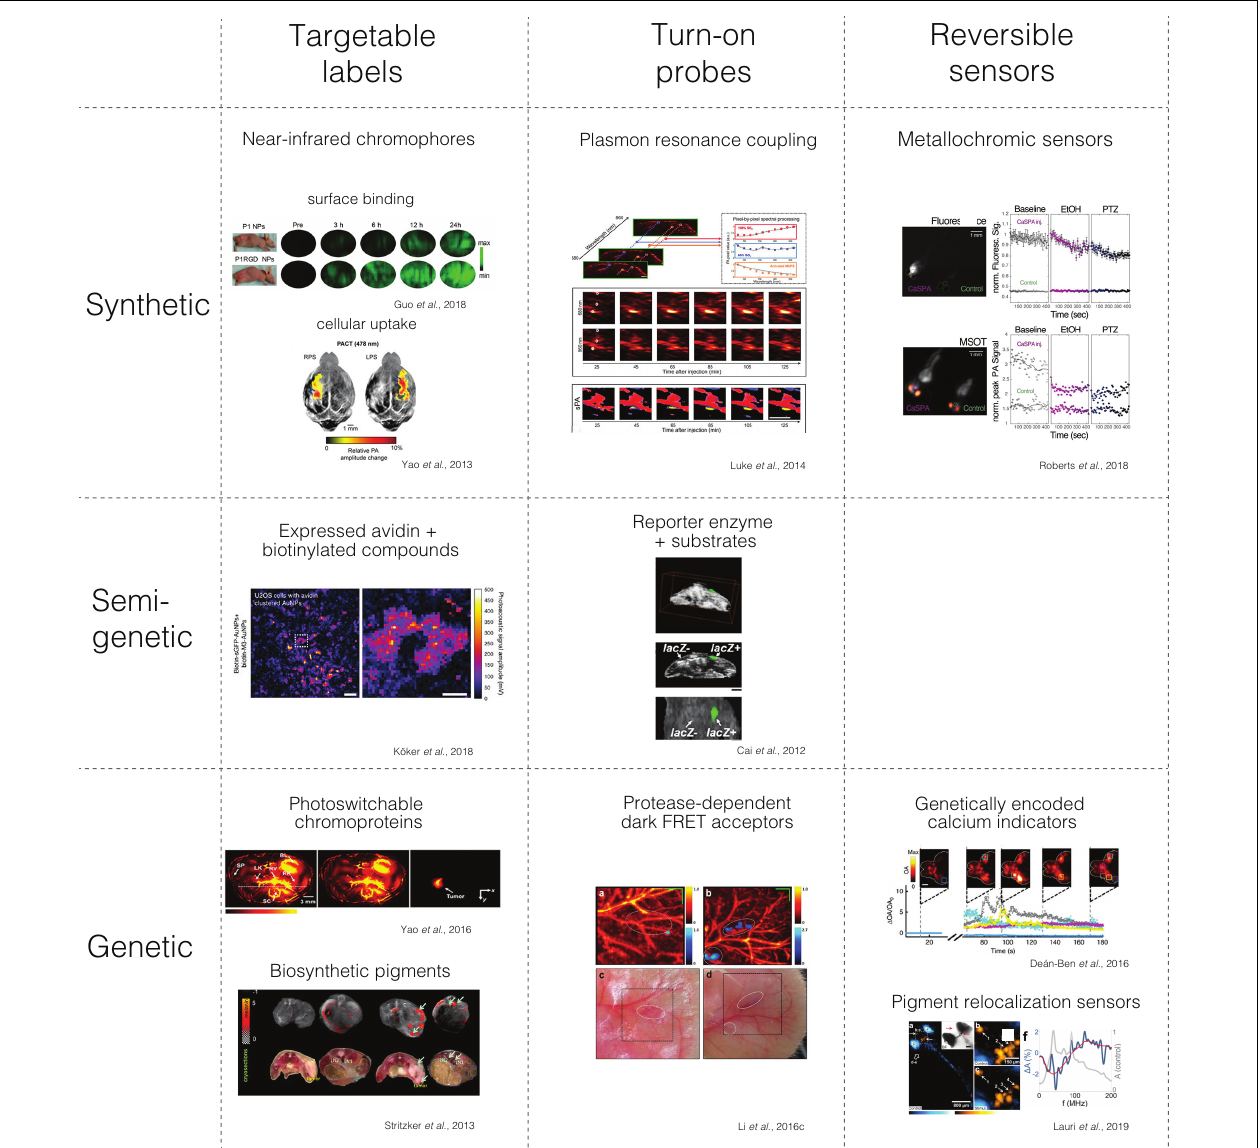
FIGURE 2 | Main classes of molecular contrast agents with examples from photoacoustic imaging. The figures were adapted from the references with permission from the authors.